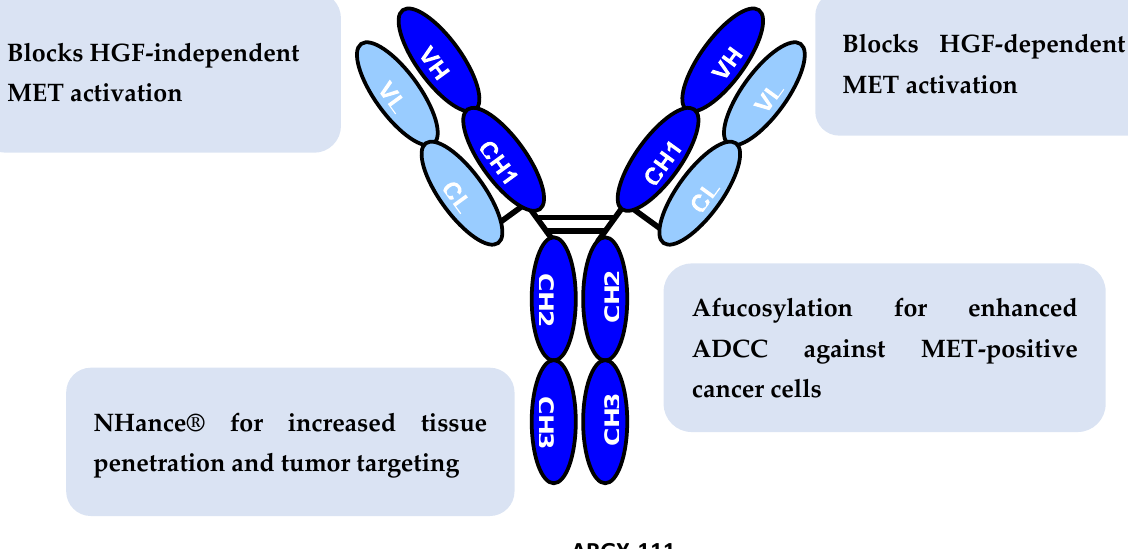
Figure 1. Modes of Action of ARGX-111. ARGX-111 combines 4 distinct mechanisms of action: (1) it potently competes with HGF for MET binding, thus inhibiting ligand-dependent MET activity; (2) it induces receptor down-regulation, thus curbing HGF-independent MET activity; (3) it engages NK cells to kill MET-expressing cancer cells, thus displaying MET-specific cytotoxic activity; and (4) it has increased tumor targeting and penetration through interaction with FcRn.